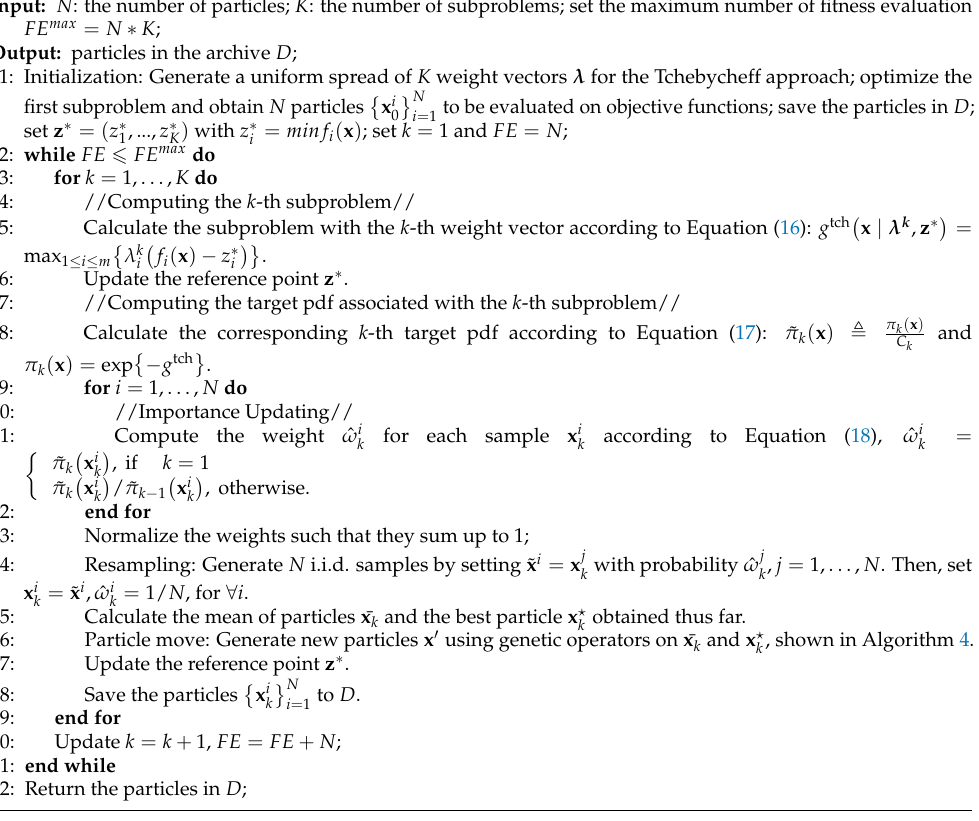
Algorithm 3 Particle filter multiobjective